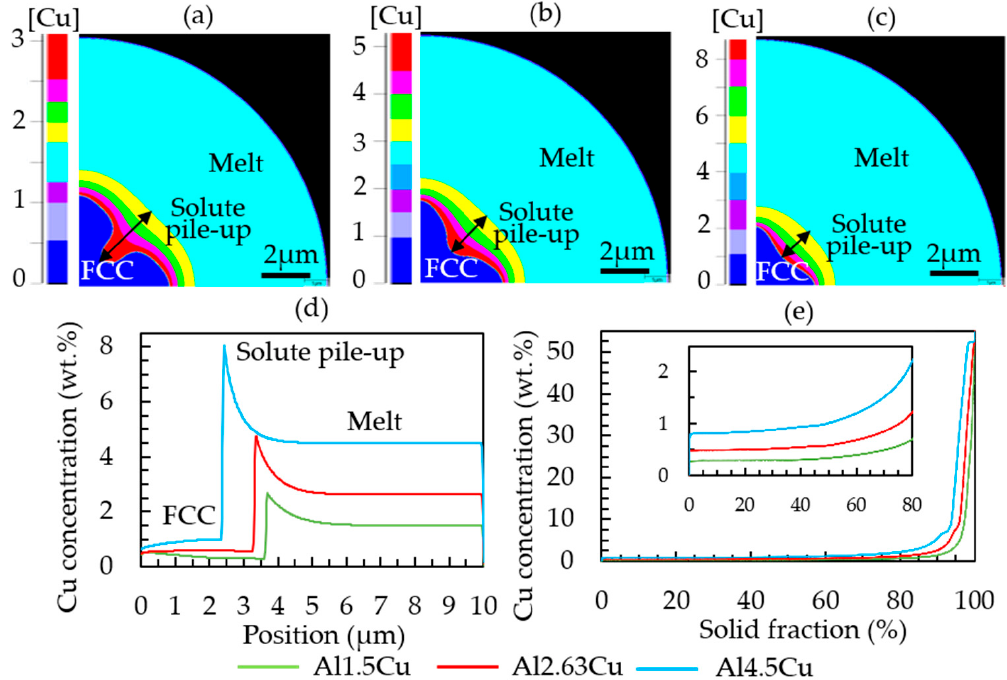
Figure 5. Diagram showing the copper pileup (in wt.%) ahead of the solid–liquid interface after 0.0004 s of growth: ( a ) Al-1.5Cu, ( b ) Al-2.63Cu, ( c ) Al-4.5Cu, ( d ) 1D plot of the Cu concentration along the Z direction from cell 1 to 500, and ( e ) sorted local copper concentration values in the completely solidified Al–Cu droplets.